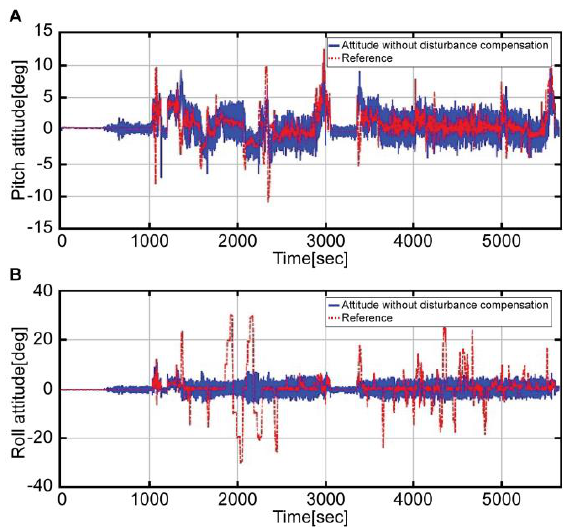
Figure 6. Attitude without compensation by the accelerometer (blue solid line) and Reference attitude (red dotted line); A: Pitch attitude, B: Roll attitude.